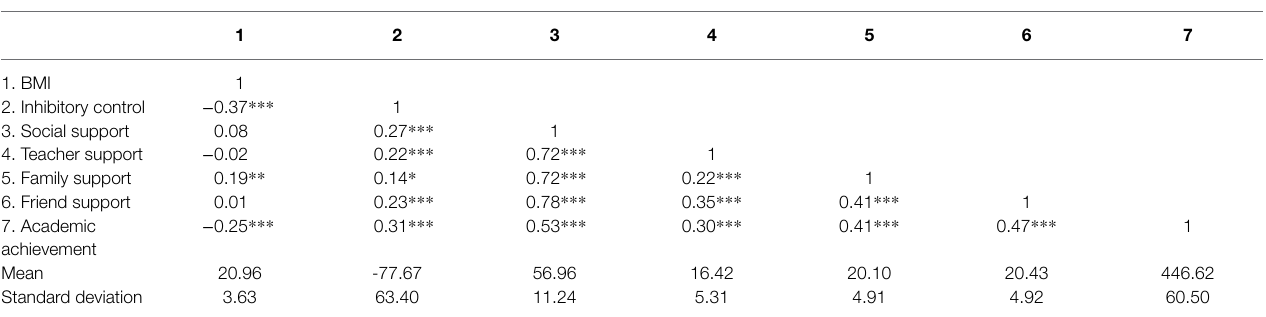
TABLE 2 | Descriptive analysis and correlation coefficients of the study